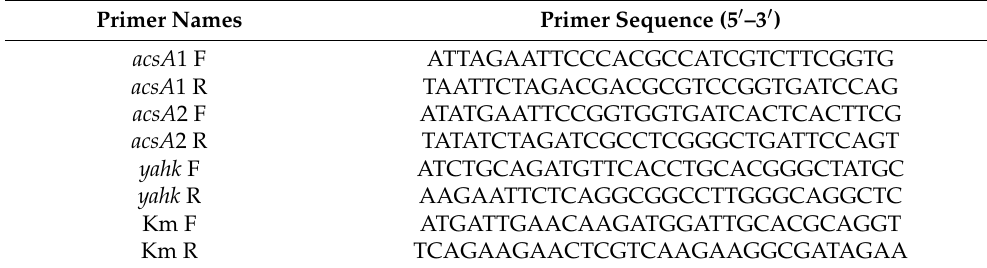
Table 2. Primers used in this